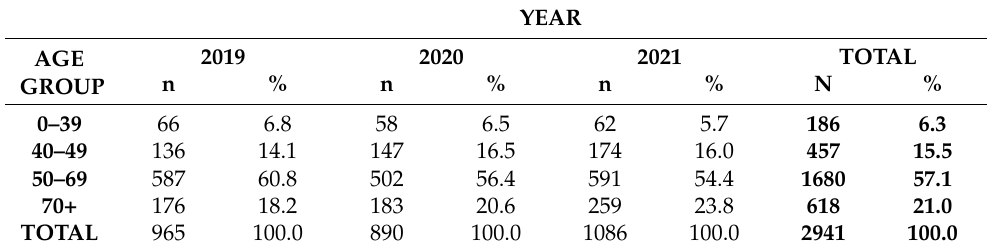
Table 5. BC cases in years 2019–2021 divided into age